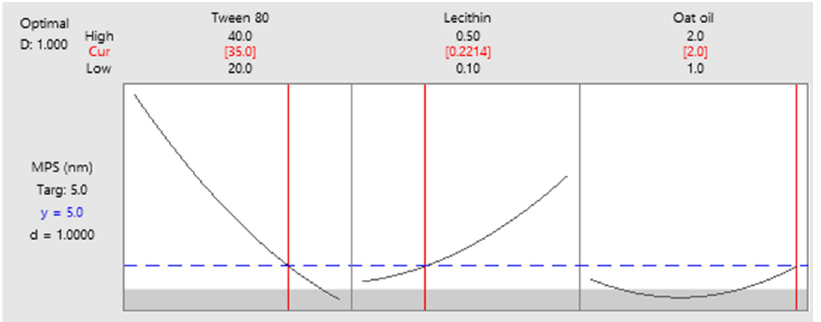
Figure 20. Predictive optimization plot for Ds response as function of three setting parameters: X 1 – kept between 30–40%, X 2 —without constraints, X 3 —maximized, with a composite desirability of 1.000.